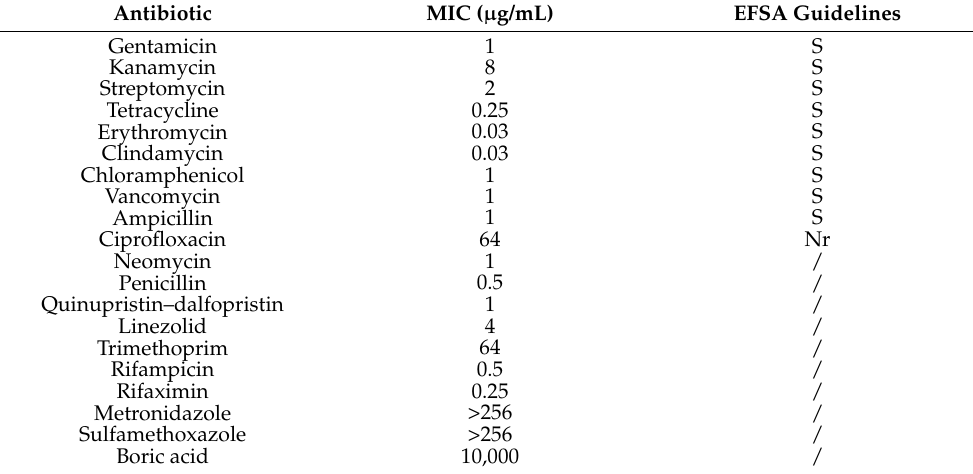
Table 1. Minimal inhibitory concentration (MIC) for L. crispatus M247 expressed in µ g/mL. S: sensitive; nr: not required; /: not mentioned in the EFSA